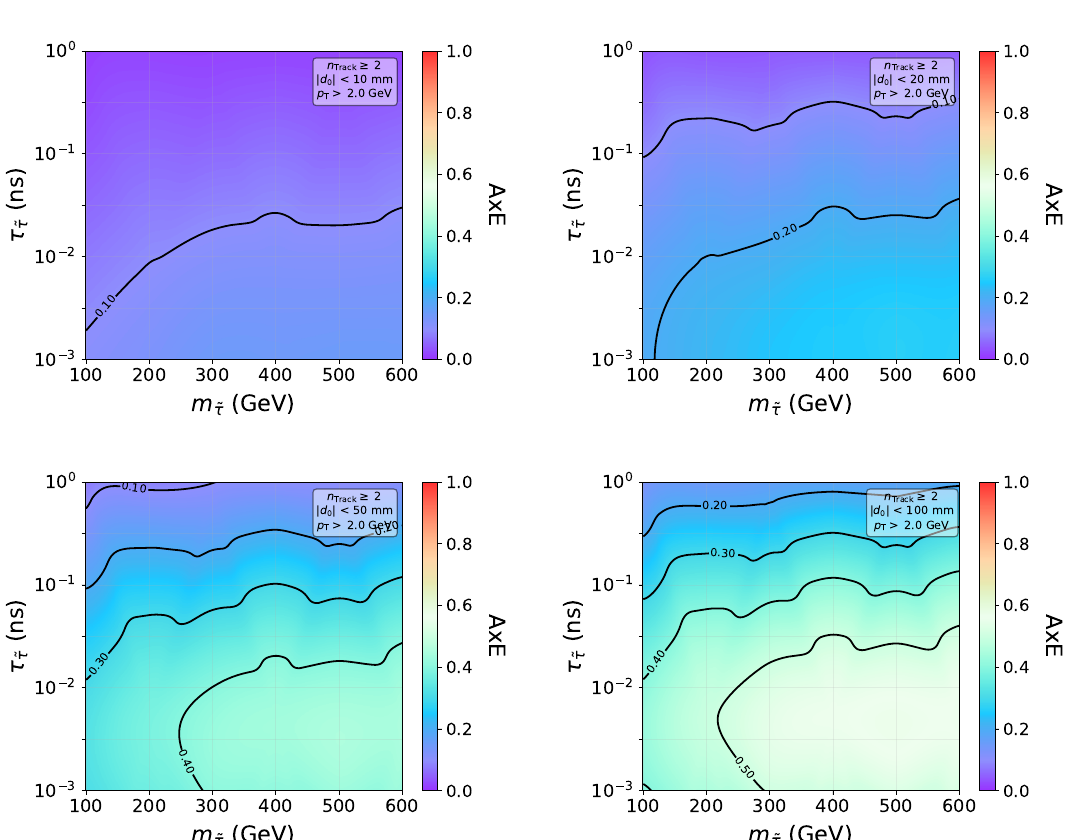
Figure 32. Event-level acceptance times efficiency for a displaced track trigger targeting the stau scenario. The constant p threshold is kept constant and | d | endpoint is varied from (clockwise T 0 from top left to bottom left) from 10 mm, 20 mm, 50 mm, and 100 mm. In all cases, the two-track selection and a linearly decreasing efficiency is